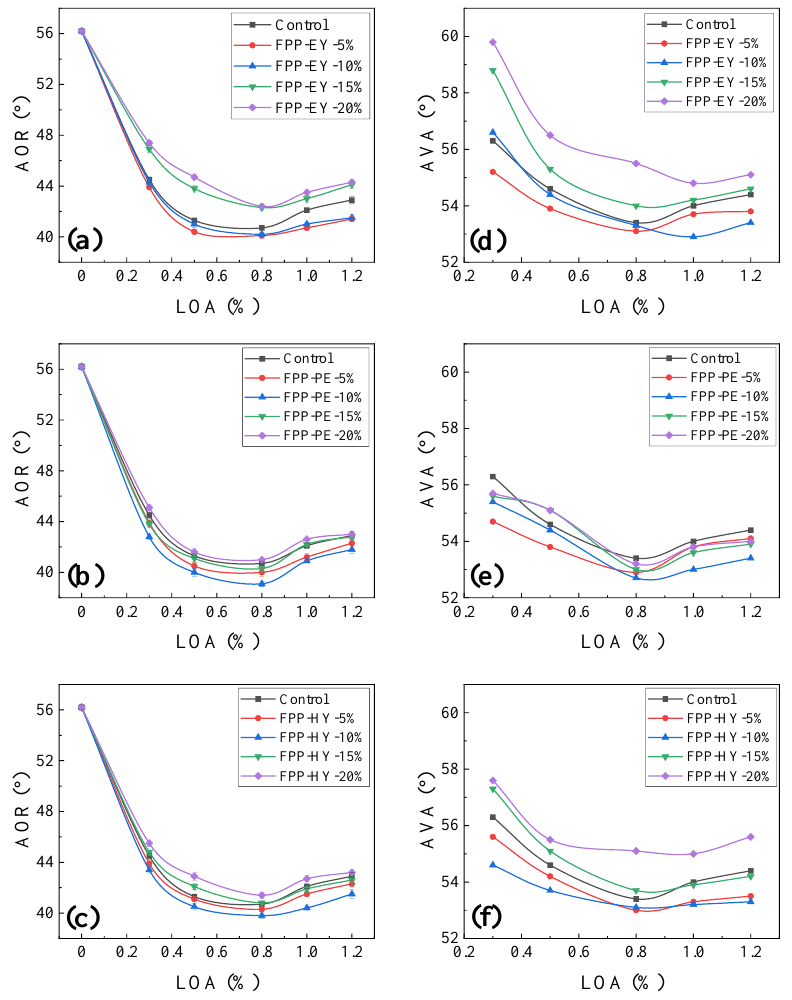
Figure 8. Effects of LOA on AOR and AVA. ( a , d ) FPP-EY; ( b , e ) FPP-PE; ( c , f ) FPP-HY.